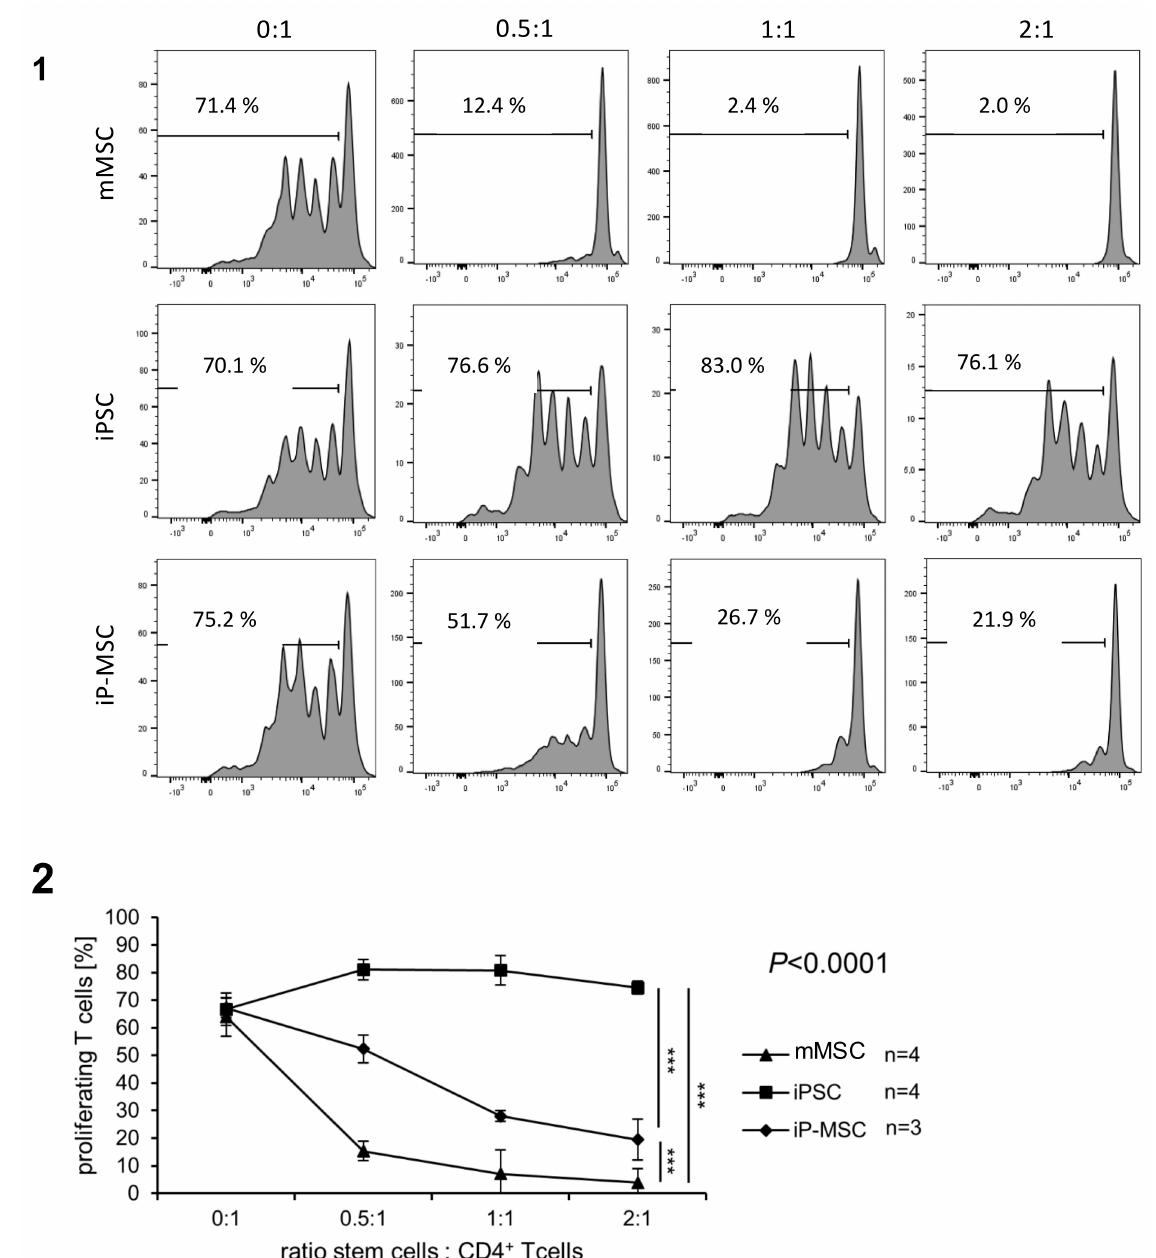
Figure 6. The capacity of nasal mucosa mesenchymal stem cells (mMSCs) to inhibit the proliferation of CD4 + T cells is mostly restored in induced pluripotent stem cell-derived mesenchymal stem cells (iP-MSCs) lines. ( 1 ) The proliferation of carboxyfluorescein succinimidyl ester (CFSE)-stained CD4 + T cells was induced by stimulation with anti-CD3 and anti-CD28 antibodies and assayed after 4 days by flow cytometry. The CD4 + T cells were cultured alone (0:1) or in the presence of mMSCs, induced pluripotent stem cells (iPSCs), or iP-MSCs derived from patient 7 at various ratios (0.5:1, 1:1, and 2:1). Histograms showing the dilution of CFSE by proliferation are displayed after gating on CD4 + T cells. The proportion of proliferating cells in this individual experiment is indicated and was determined using the marker shown in the histograms. ( 2 ) A summary of results showing means and standard deviations (SD) obtained with several cell lines is displayed. Significant differences between the cell types were revealed by 2-way ANOVA adjusted to the cell ratios 0.5:1, 1:1, and 2:1, and the respective p -value is displayed in the diagram. Post hoc analyzes indicated that the inhibitory capacity was different between the cell types (*** p <